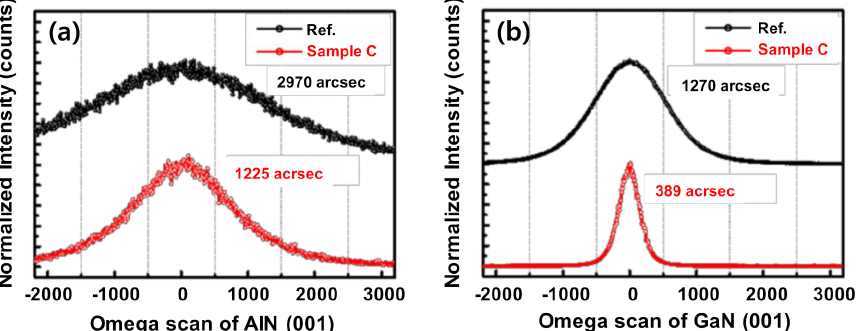
Figure 2. X-ray diffraction (XRD) Omega scan of reference and sample C ( a ) AlN (001) and ( b ) GaN